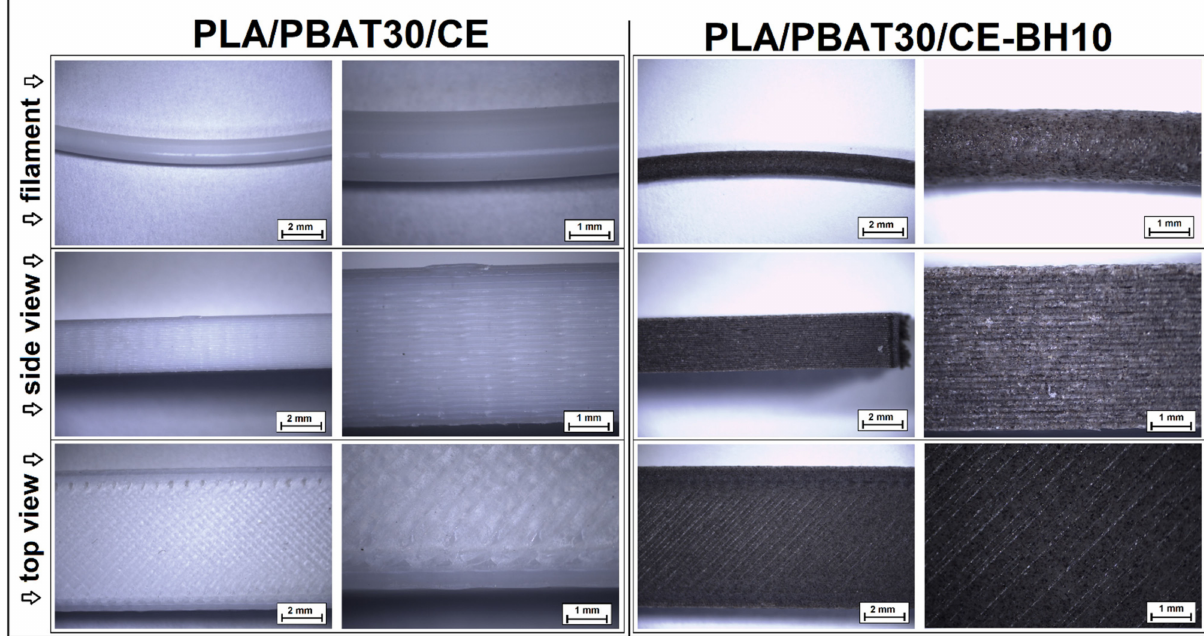
Figure 4. The appearance of the prepared unfilled PLA/PBAT30/CE blend and reinforced PLA/PBAT30/CE-BH10 samples. Pictures present the filament material, and side and top view of the printed